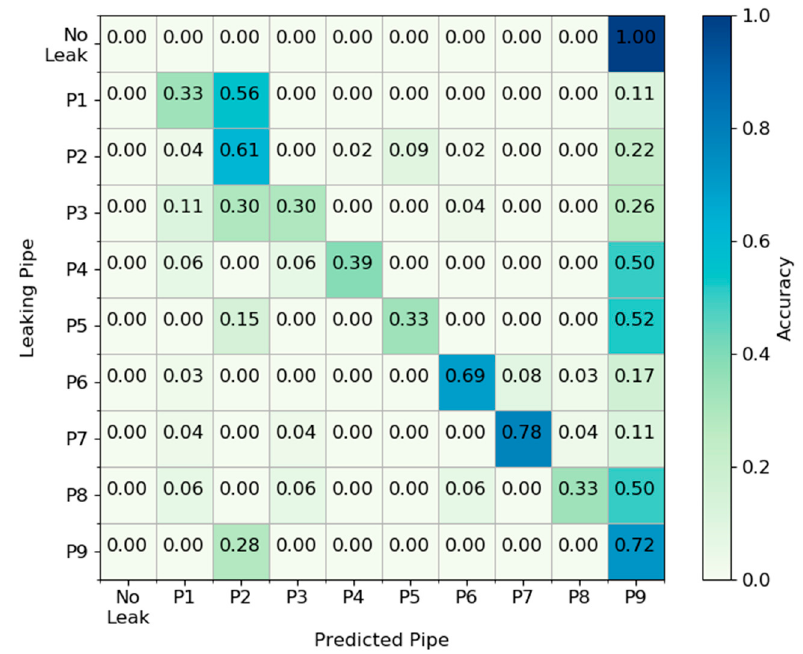
Figure 6. Tnet1 K-NN second validation.